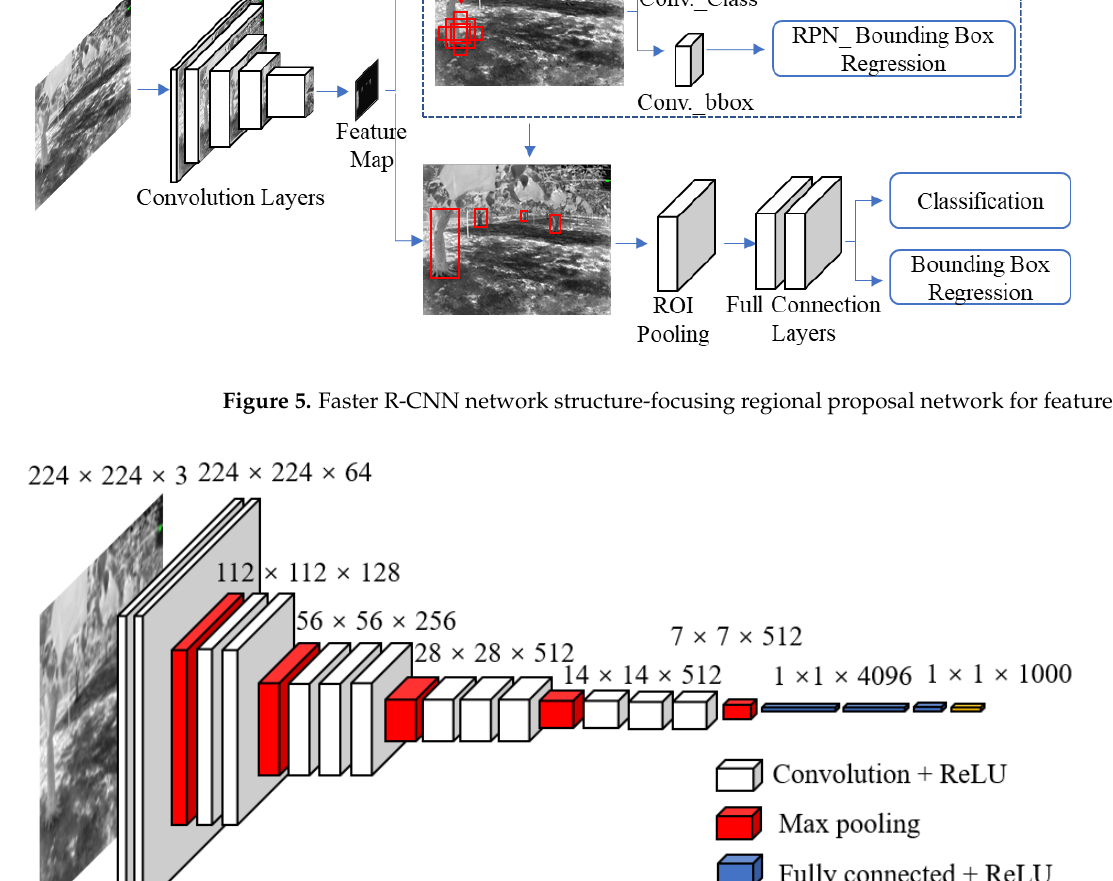
Figure 5. Faster R-CNN network structure-focusing regional proposal network for feature map.